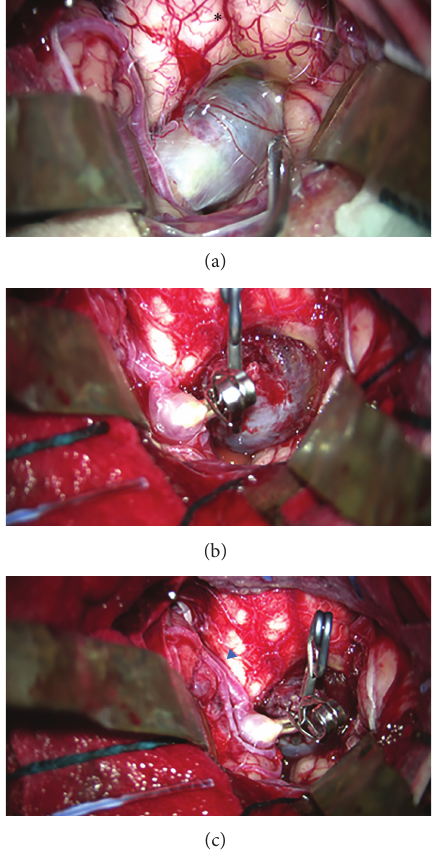
Figure 2: Operative photographs showing a well-encapsulated lesion upon lateral retraction of the cerebellar hemispheres ((a); asterisk, inferior medulla). Further dissection revealed a large aneurysm of the left distal PICA telovelotonsillary segment ((b), (c); blue arrowhead, PICA). Subsequent clipping of the aneurysm neck was performed with preservation of the PICA trunk ((c); blue arrowhead, PICA).